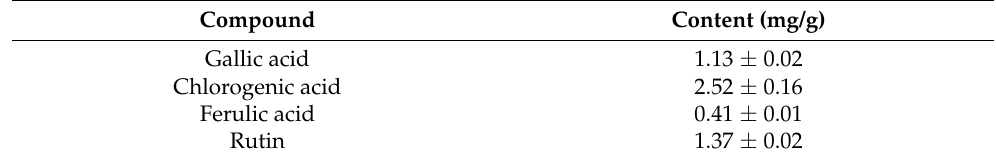
Table 3. Phenolic compounds identified in